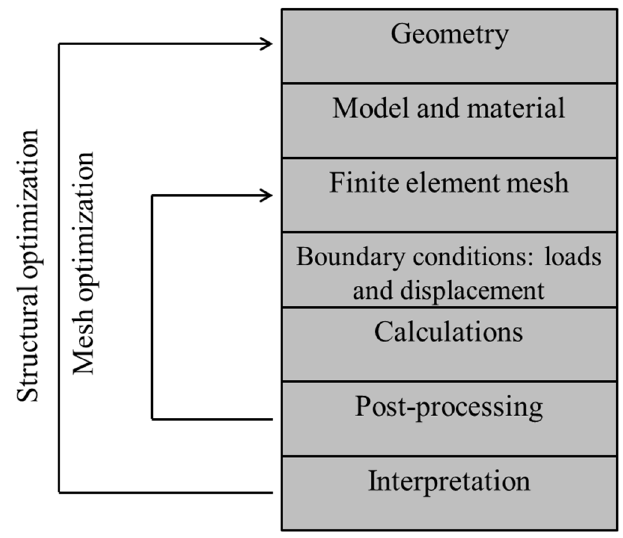
Figure 6. Typical finite element